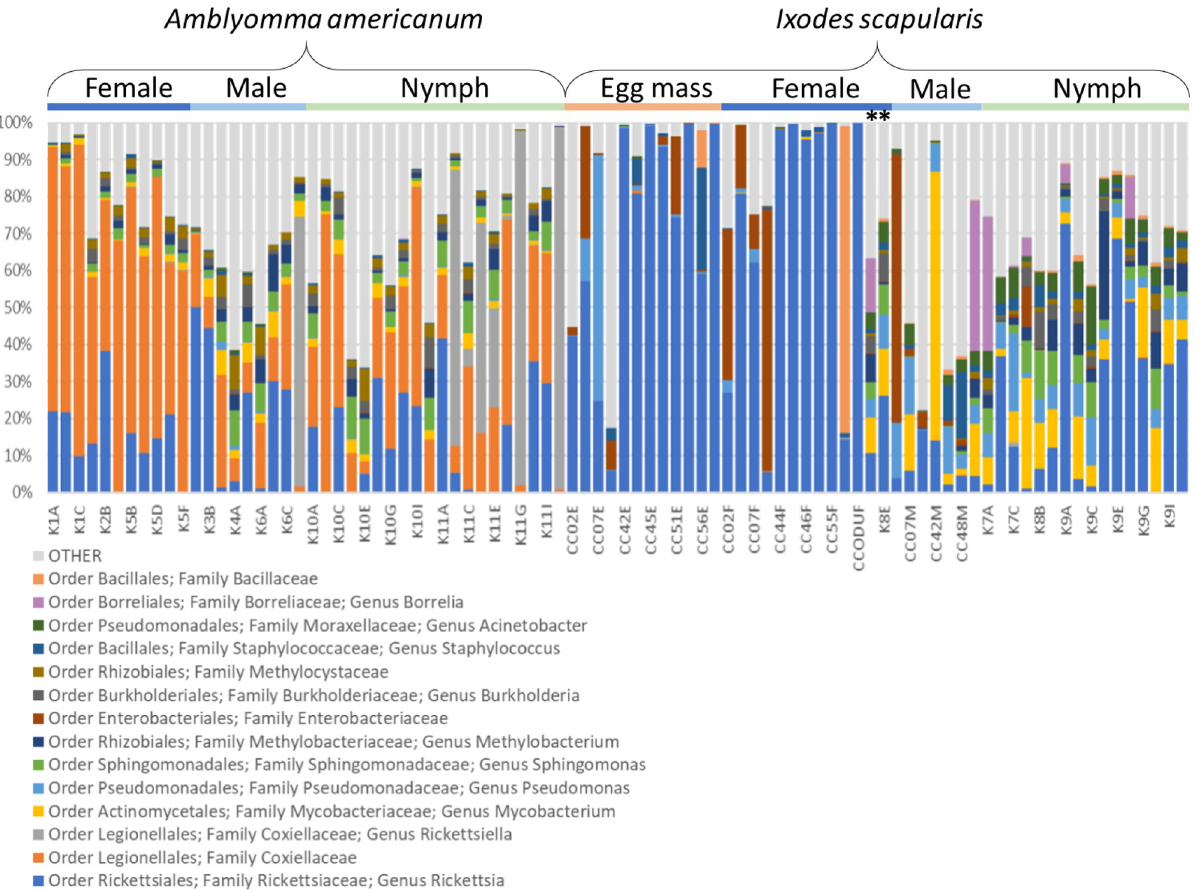
Fig 3. Relative abundance of the 15 most commonly-detected OTUs in this study, organized by tick species and life stage. Taxa (order, family, and genus where available) are listed below the figure. Sample numbers are listed alphabetically within a life stage group and areindicated along the x-axis. Specific samples can be identified either by their labels along the x-axis or, if unlabeled, can be derived from the list of samples (S1 Table). Asterisks indicate two unengorged host-seeking female ticks that were collected during drag sampling; all other female ticks included in this figure were engorged and the time of